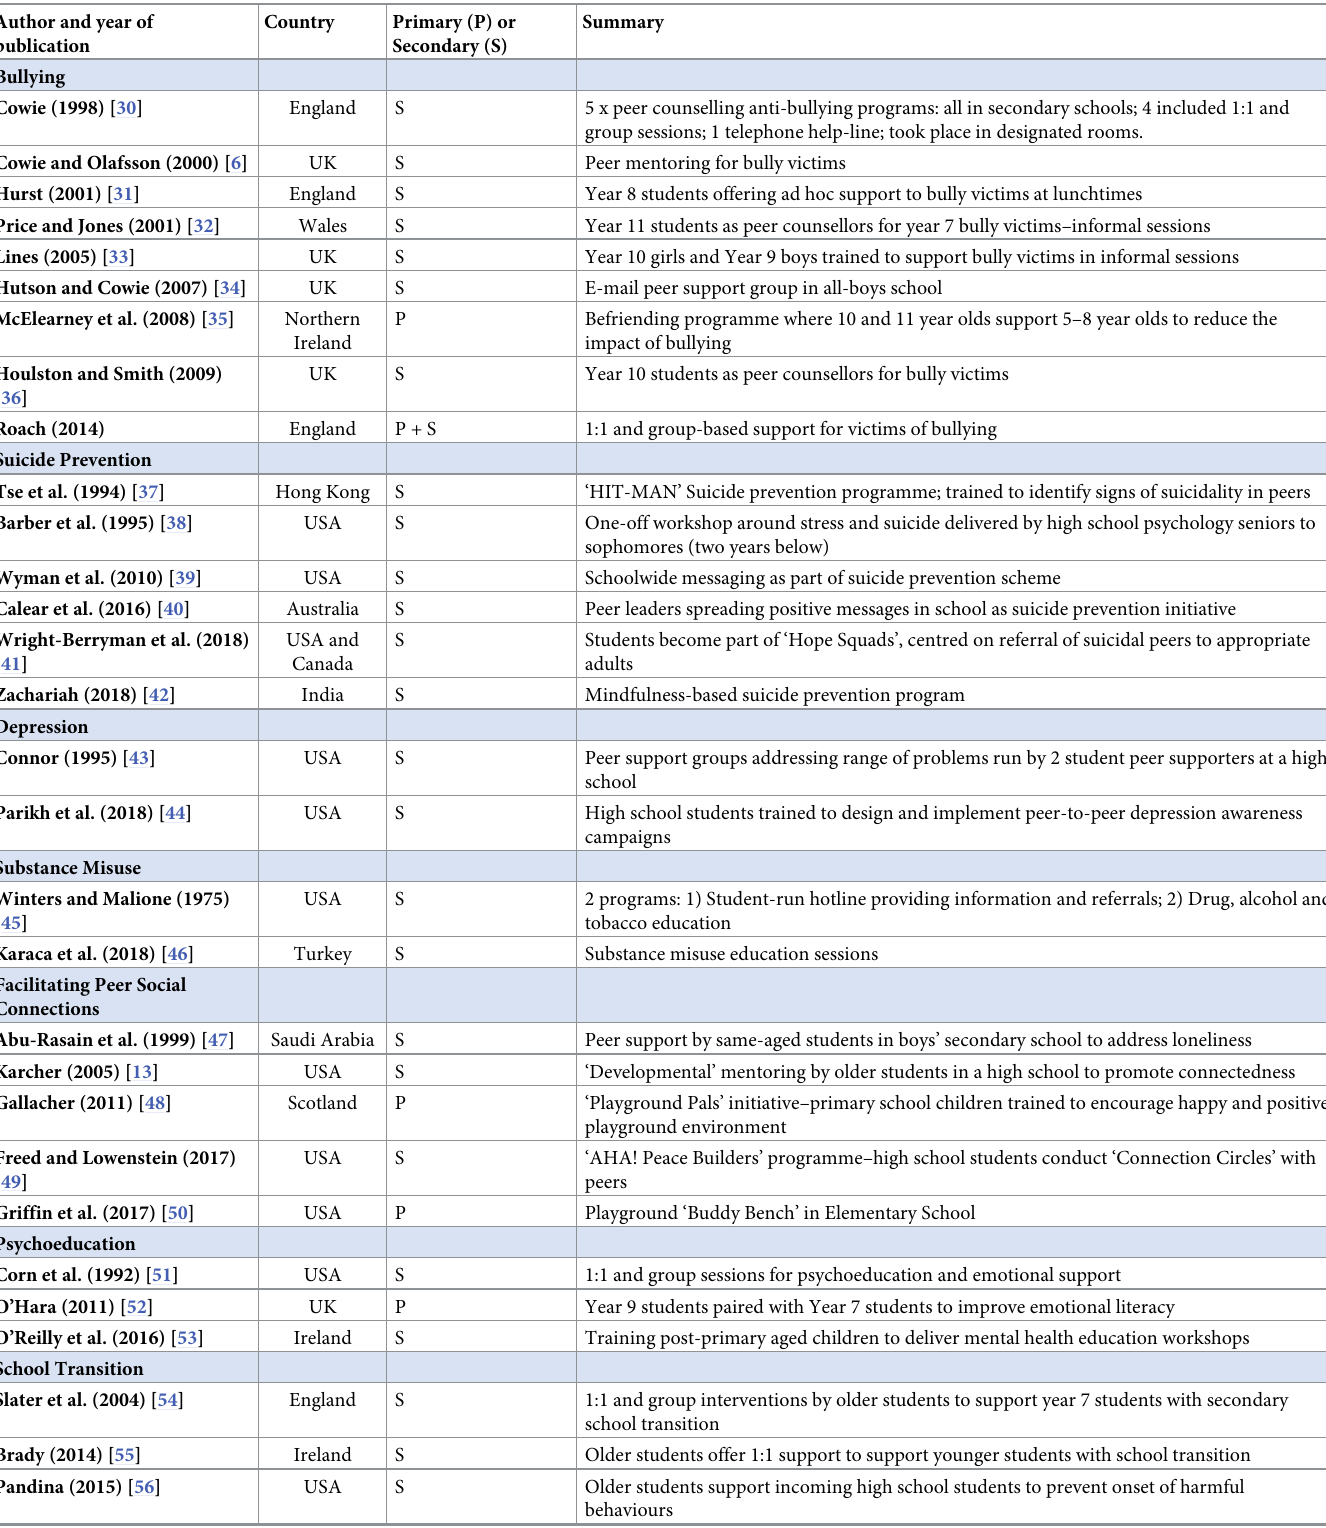
Table 1. School-based peer-led interventions identified in scoping